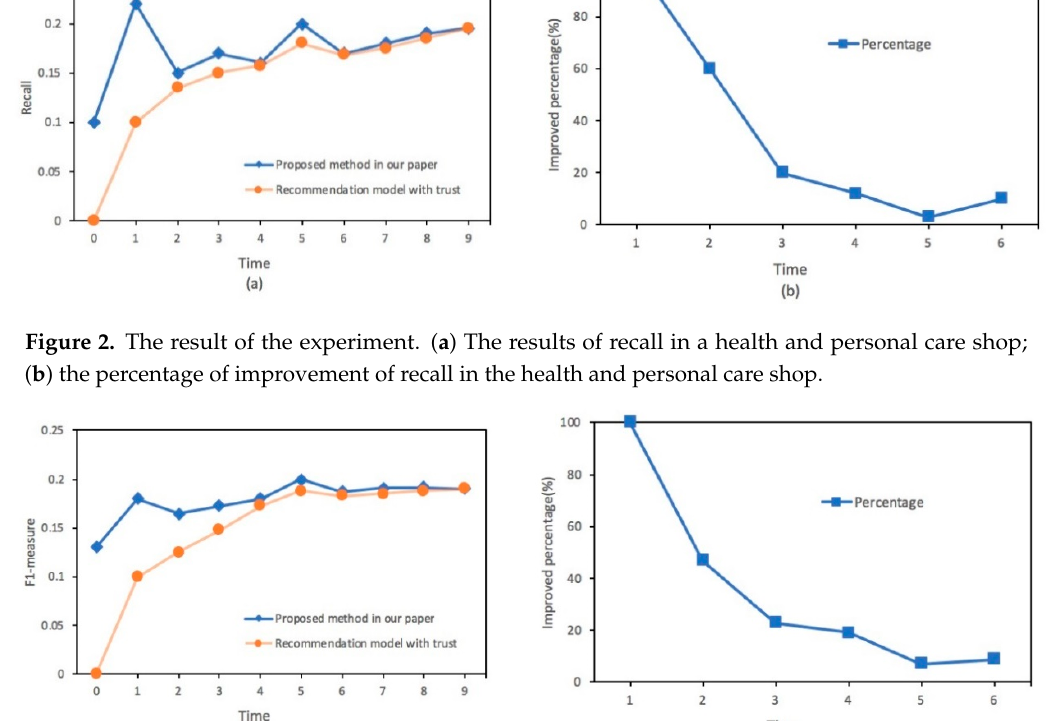
Figure 4. The result of the experiment in the health and personal care shop. ( a ) The results of precision under different recommendation thresholds; ( b ) the percentage of improvement of precision under different recommendation thresholds.